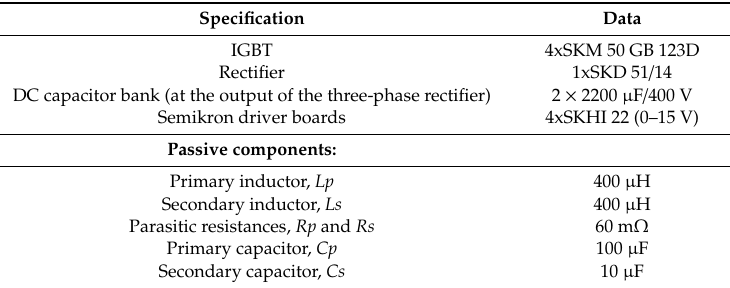
Table 6. Components of the SIBC converter